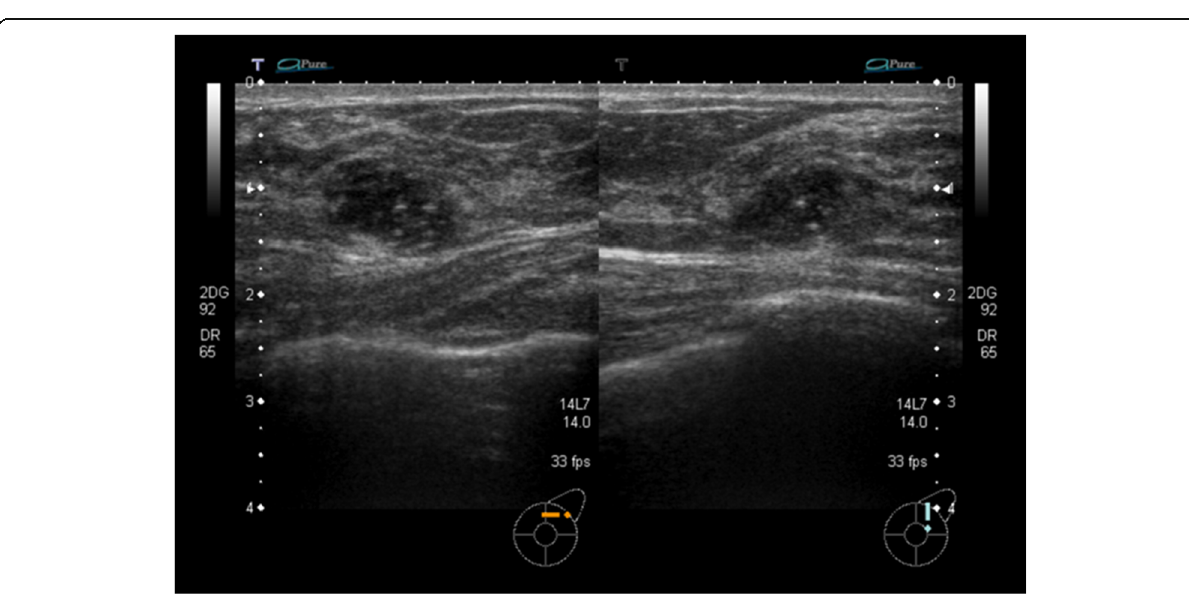
Fig. 1 Mammogram. Mammogram showing clustered pleomorphic calcification in the left MLO-M area ( a ) and CC-O area ( b ). c , d Enlargements of the areas indicated by yellow arrows